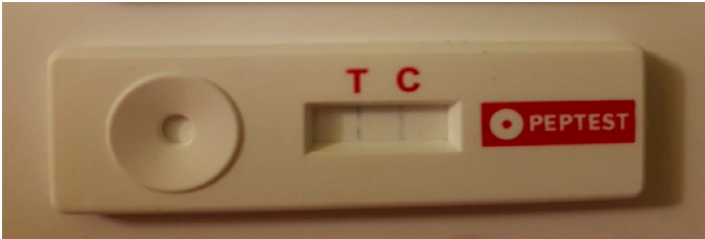
Figure 1. The salivary pepsin concentration test (PEP-test): The existence of the T band indicates that pepsin is present in the tested sample and, furthermore, the intensity of the T band is directly proportional to the pepsin quantity.